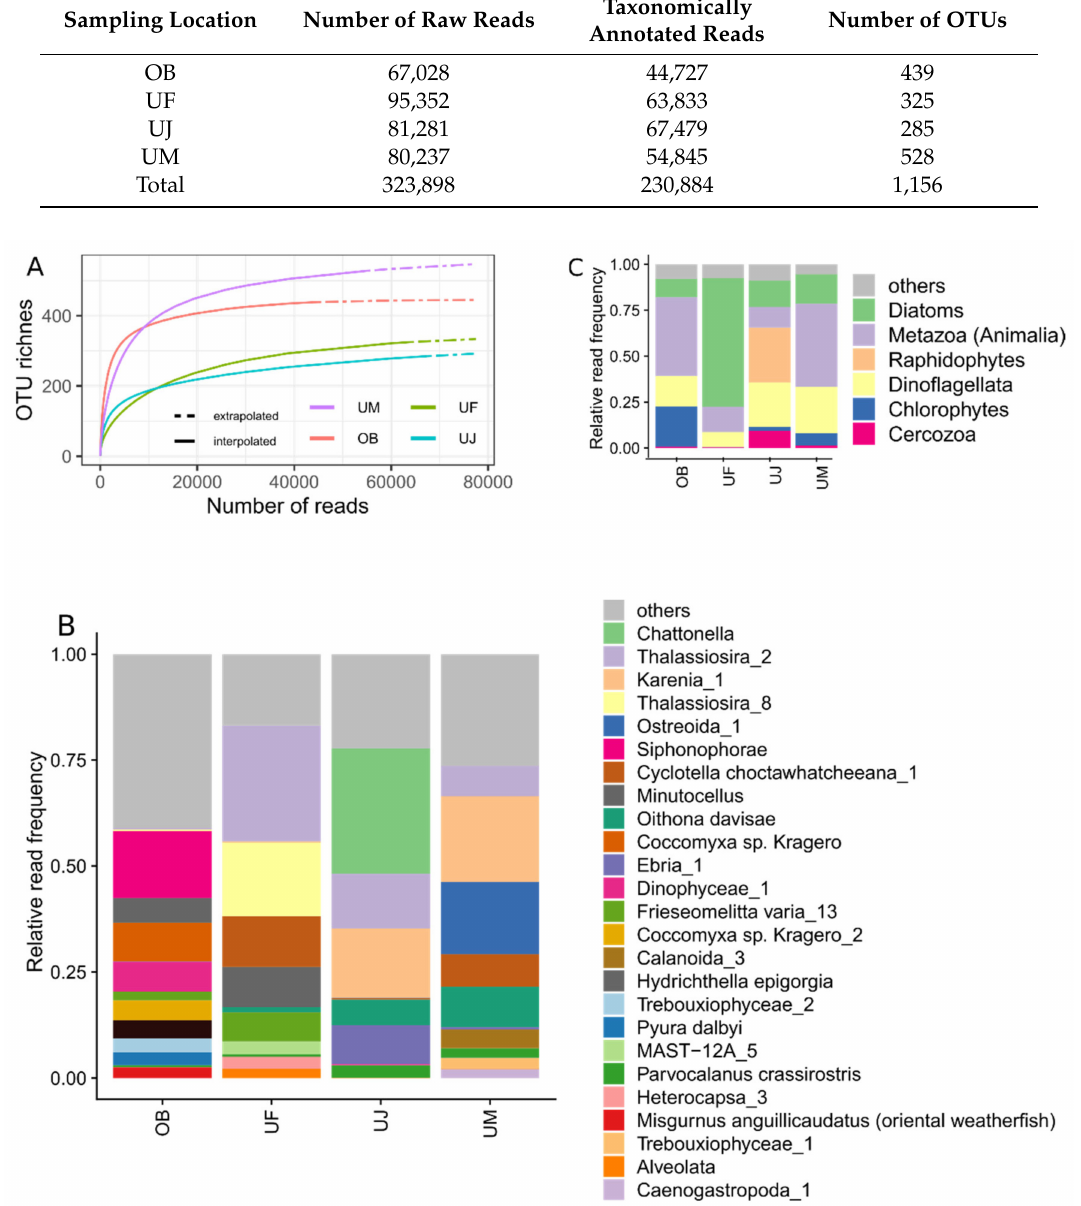
Figure 6. Eukaryotic communities in four samples. ( A ) Rarefaction curves for the number of OTUs in four samples based on 18S rRNA gene amplicon analyses. ( B ) Relative frequencies of eukaryotic OTUs across samples. OTUs are represented by bars with colors if their relative frequencies reach at least 2% in any dataset, otherwise OTUs are grouped together in the “others” category. ( C ) Relative frequencies of major eukaryotic lineages in four